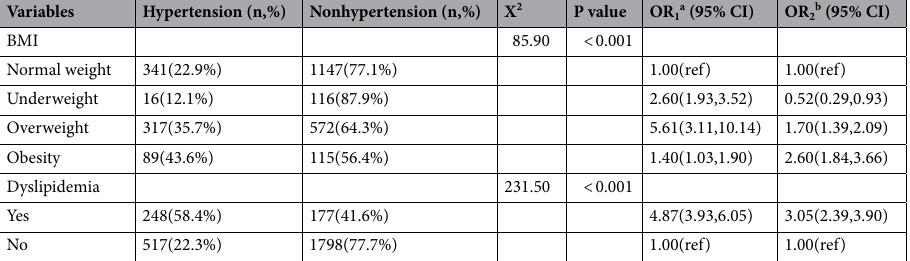
Table 2. Independent effects of BMI and dyslipidemia on the risk of hypertension. a OR 1 is the result of univariate analysis. b OR 2 is the result of multivariate analysis. The adjusted confounding factors included sex, age, diabetes, education level and